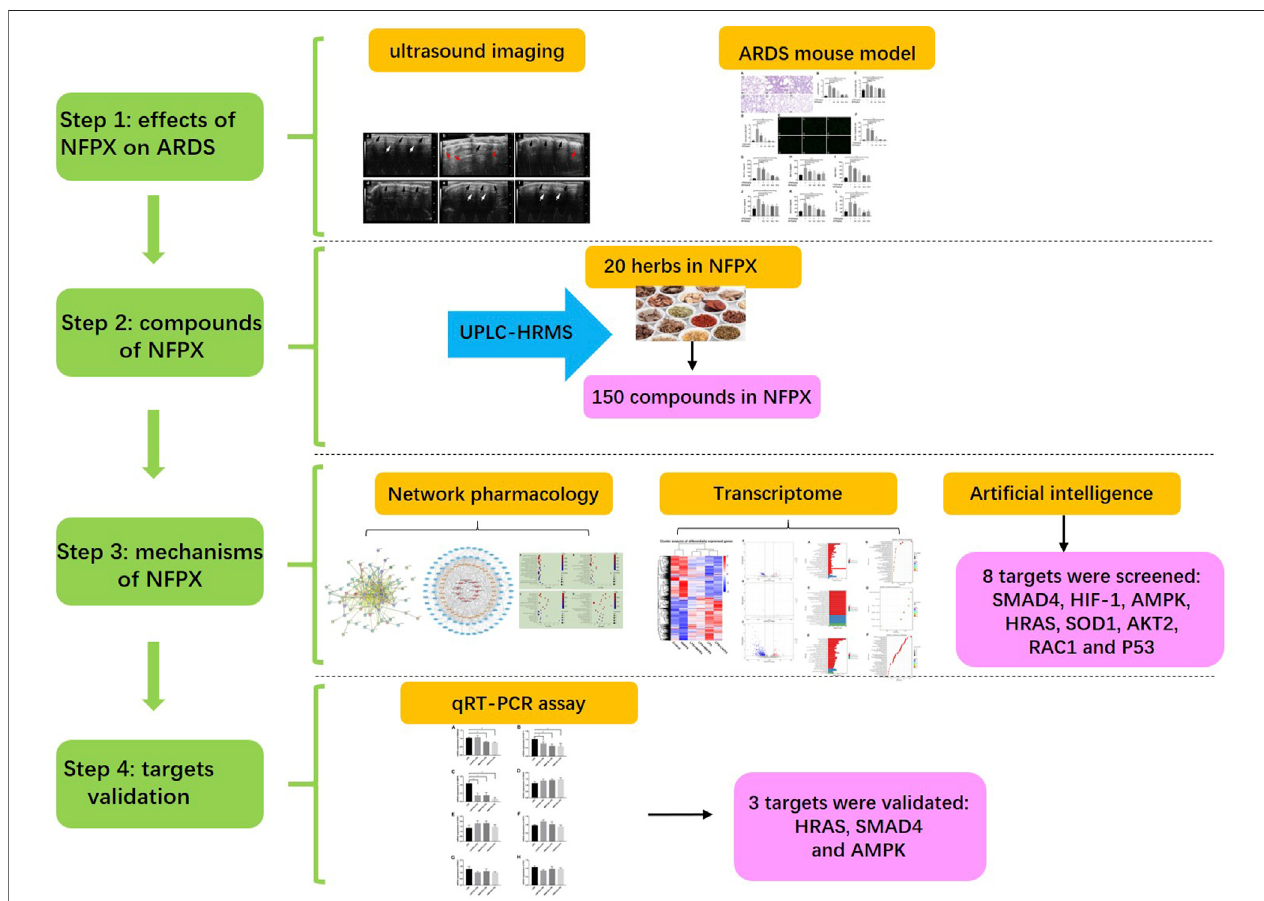
FIGURE 1 | The schematic of the work fl